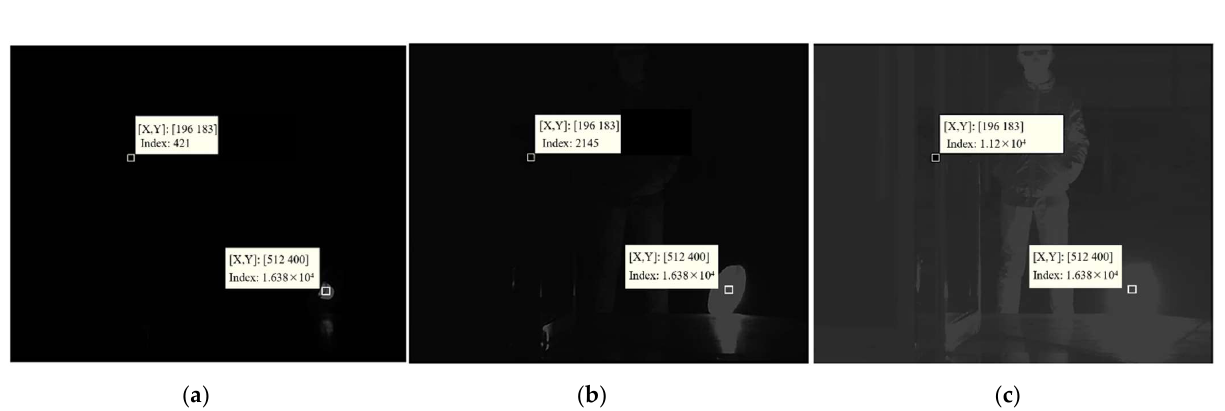
Figure 6. Distribution of gray levels in a set of scene maps: ( a ) 13 μs; ( b ) 665 μs; ( c ) 1330 μs. As mentioned earlier, the grayscale difference of pixels in the ambient-temperature ( ) G T region is not large, so the second coefficient, (less than 1), is used, which H ( ) ( ) G T G T H L determines the range from the “seed” grayscale to the high-temperature grayscale. This means that the pixels with a slightly larger grayscale than the seed point should also be considered as part of the ambient-temperature region, but this range does not exceed the grayscale of the seed point itself. When the integration time increases, the grayscale of the ambient-temperature region increases, but the high-temperature region is basically in a saturated state, with little change in grayscale, and the second coefficient decreases ac- cordingly. It means that the range is being defined as the ambient region decreases, which avoids the error of pixels in the high-temperature region being divided into the ambient- temperature region under high integration time. As shown in Figure 7, for an image with 1995 μs, the pixels with grayscale smaller than 1.74 times that of the seed point can be defined as the ambient-temperature region, and a good segmentation effect is achieved, as shown in Figure 7b. However, if 1.2 times is used, the ambient-temperature region (e.g., the clothing) is also defined as the high-temperature region, as shown in Figure 7a; if 3 times is used, almost all pixels are defined as the ambient-temperature region, as shown in Figure 7c. ( a ) ( c ) Figure 7. Segmentation results of different segmentation parameters at integration time 1995 μs: ( a ) 𝜇(1995) = 1.20; ( b ) 𝜇(1995) = 1.74; ( c ) 𝜇(1995) = 3.00. The images were divided by markers F into two major ranges, R L ( T ) and R H ( T ). The segmented images obtained in Figure 8 correspond to the integration time of the scene imaging sequence in Figure 2. It was experimentally verified that the image quality of the region (including sharpness, contrast, and good exposure) is centered on the average grayscale as a parabolic function, with an approximate opening downward. Part of the